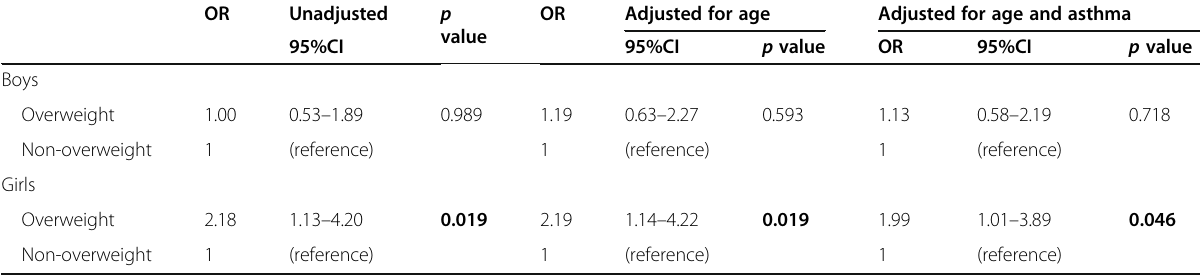
Table 5 The association between overweight and food allergy using multiple logistic regression analysis OR Unadjusted p OR Adjusted for age Adjusted for age and asthma value